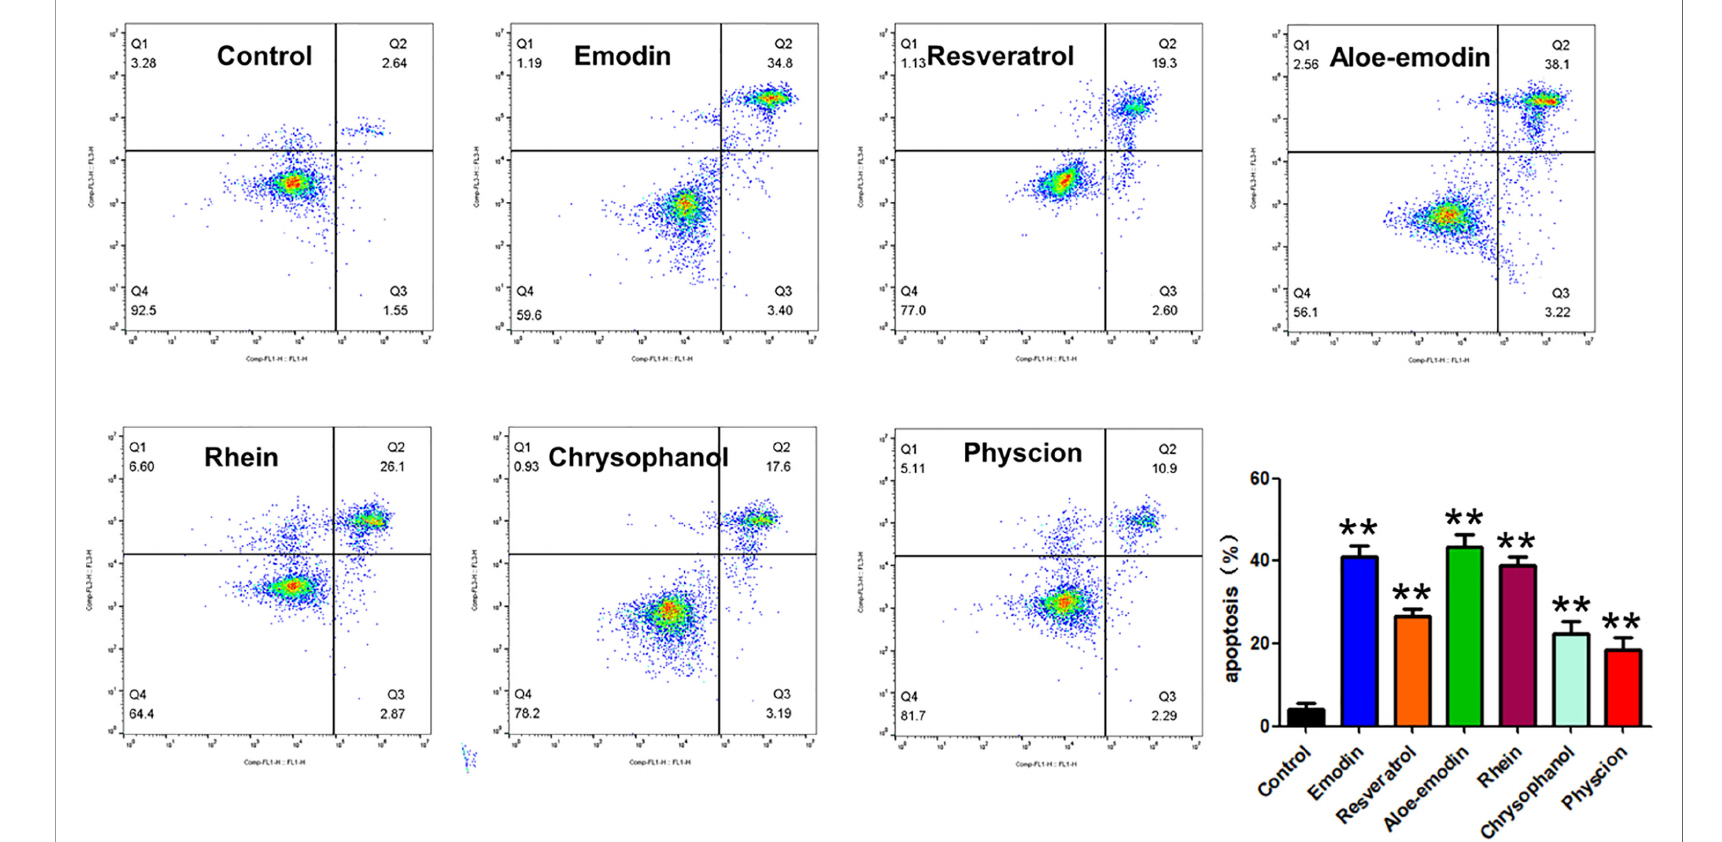
FIGURE 11 | Apoptotic induction activities of emodin, resveratrol, aloe-emodin, rhein, chrysophanol, and physcion on A549 cells. Cells were treated with candidate drugs (6 µg/mL) for 24 h, and the apoptotic cells were detected by staining with Annexin V-FITC/PI followed by fl ow cytometry analysis. Data were expressed as mean ± SD (n = 3), and asterisk indicated signi fi cant difference, ** p < 0.01 vs.